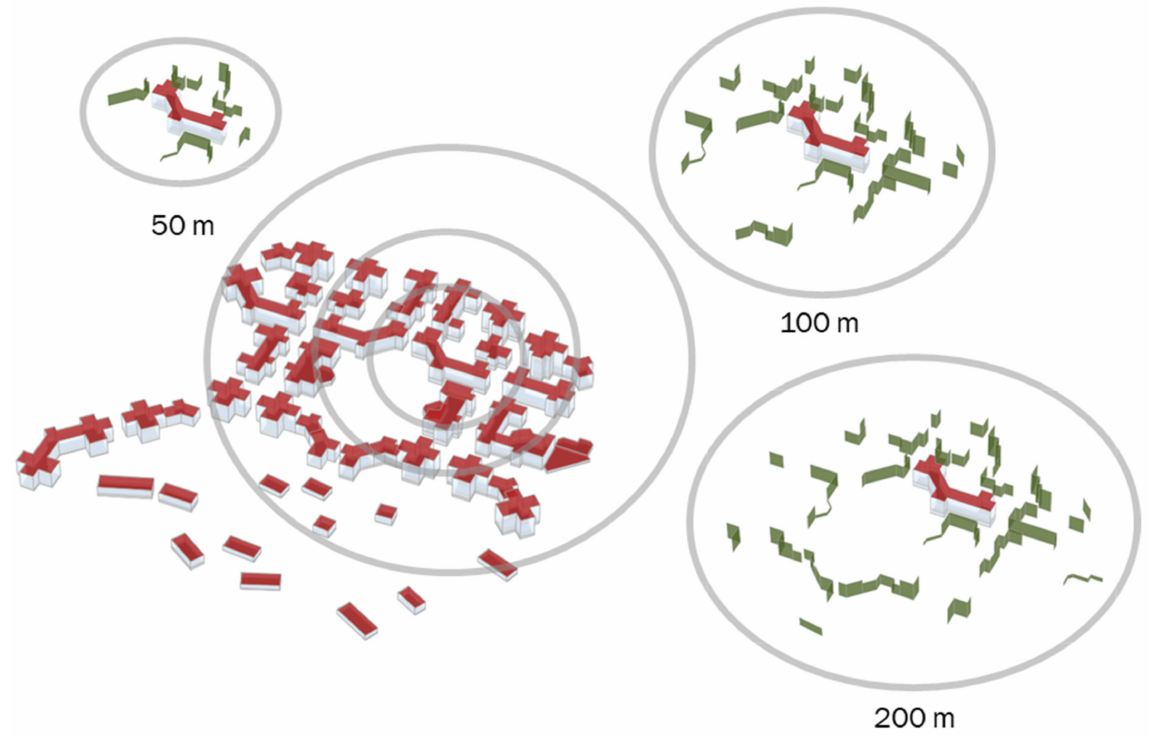
Figure 4. Shadowing effect for the environment of a random building, based on the distance thresh- olds (50, 100, and 200